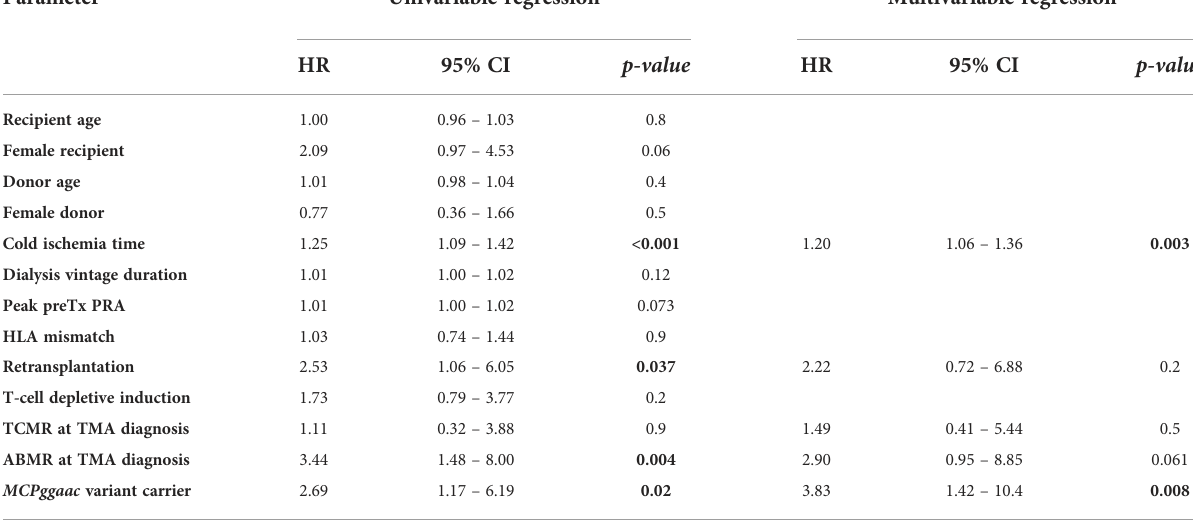
TABLE 4 Factors associated with 3-year death censored graft survival in the TMA group, univariable and multivariable Cox regression.